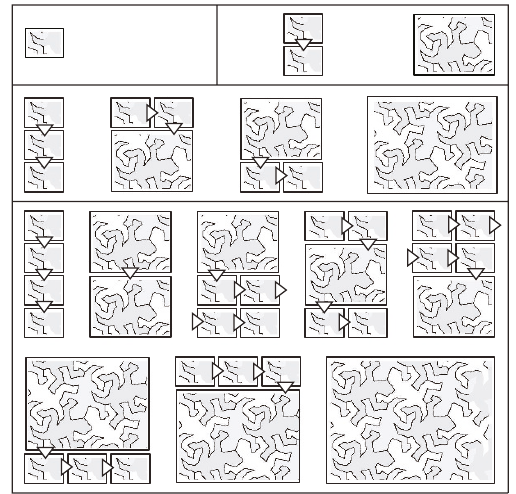
Figure 4: Panel templates for panel heights 1 to 4. Arrows show the temporal sequence of images for each template, adopted from the narrative structure in